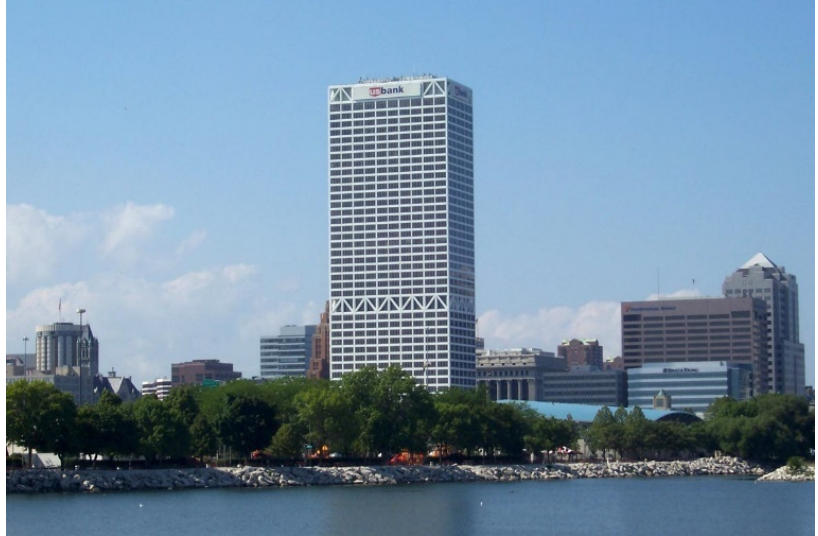
Figure 6. The US Bank (1973) in Milwaukee, WI, showing the belt trusses. (Source: Wikipedia). The core-outrigger systems may be formed in steel, concrete, and composite systems. These systems allow the perimeter columns to be widely spaced, thereby opening the building’s exterior by reducing the obstruction created by the closely spaced columns